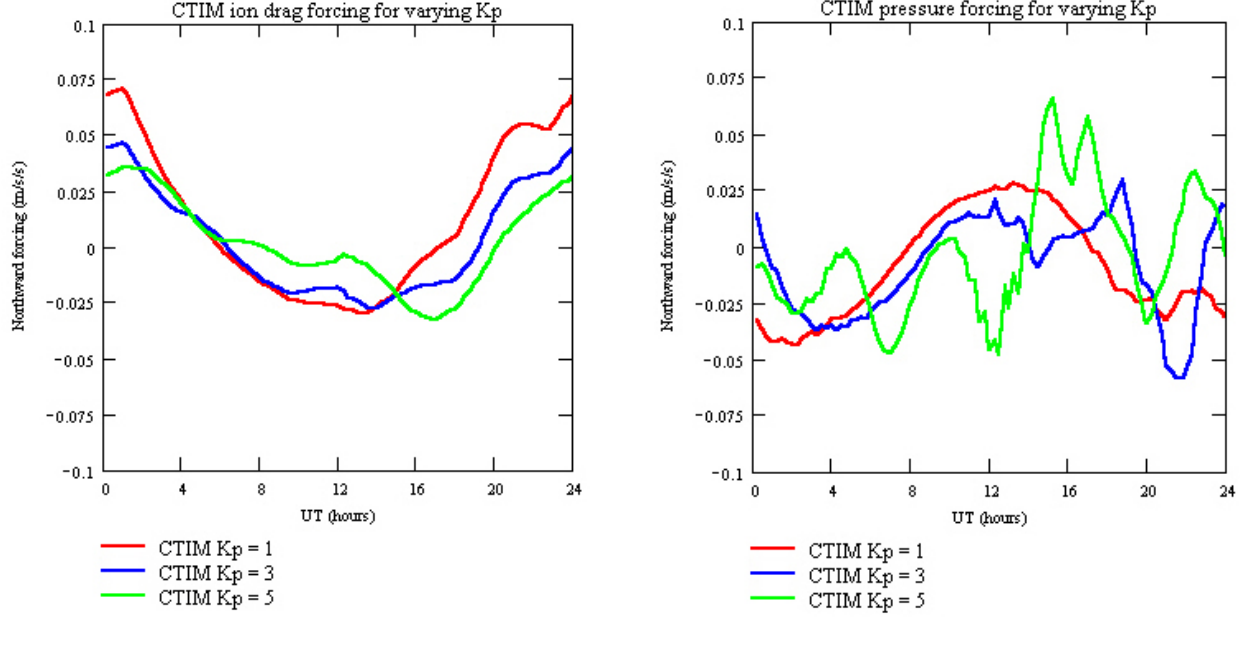
Fig. 9. The pressure gradient acceleration through the day for the same K p levels as in Fig.